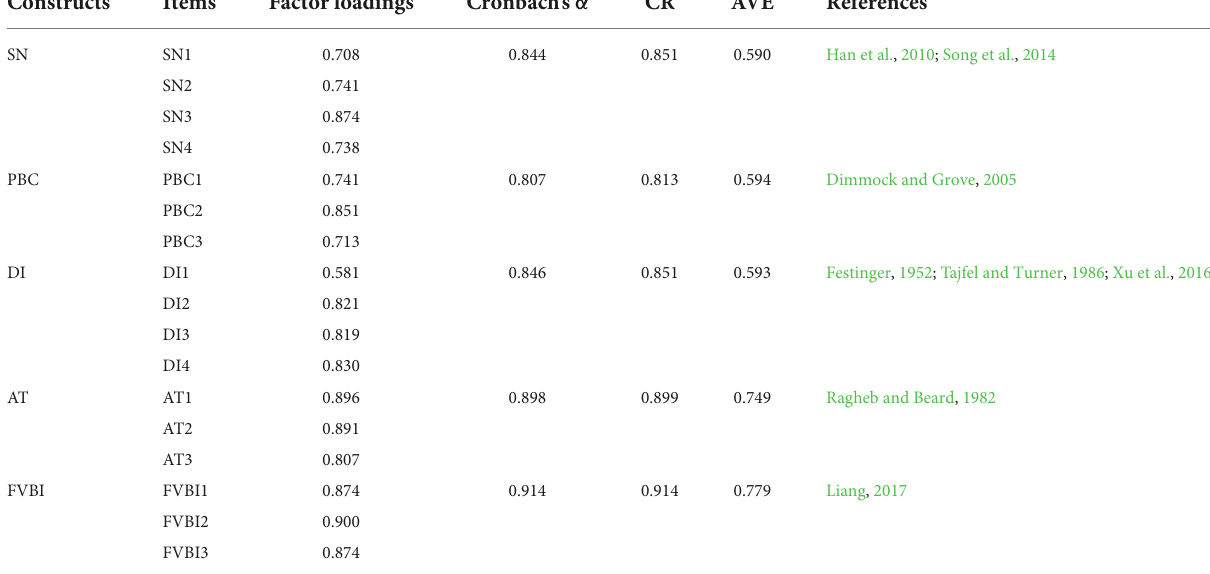
TABLE 3 Reliability and validity testing of our scale.